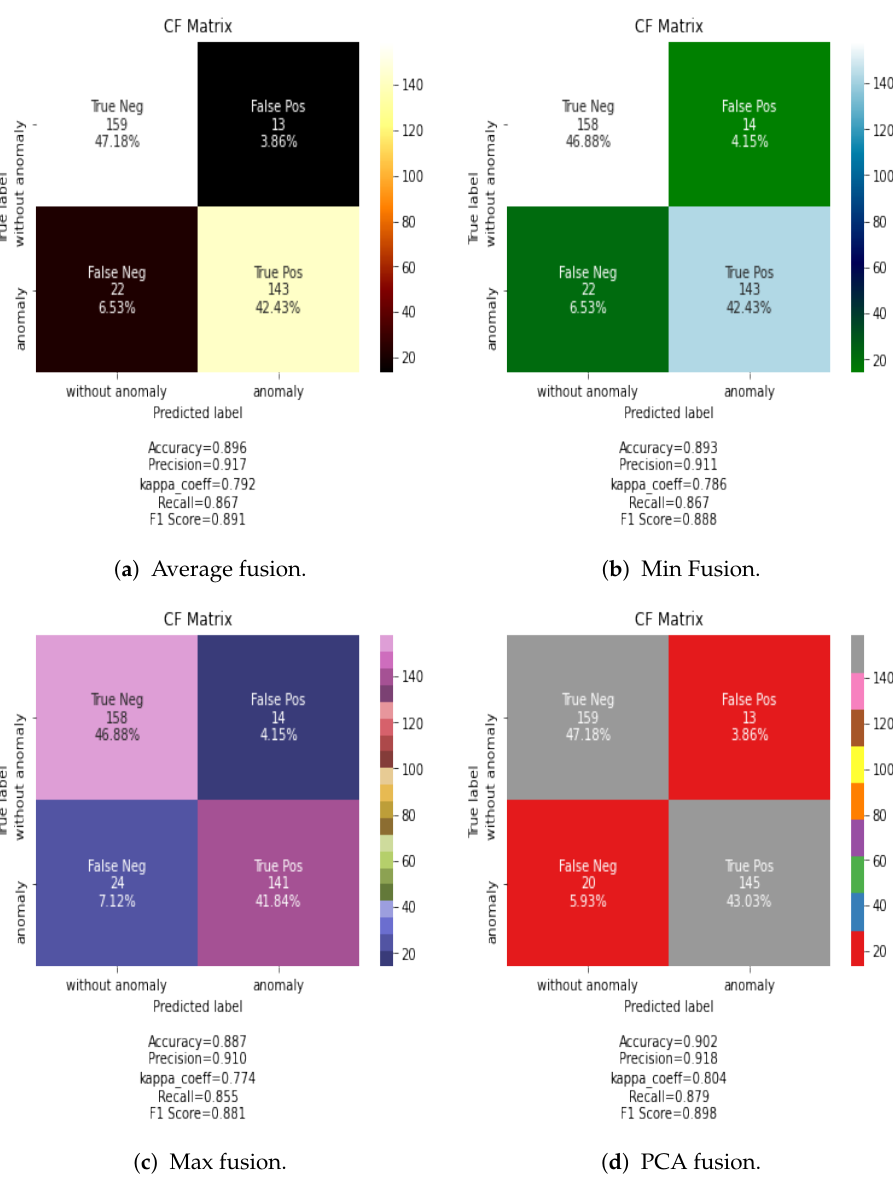
Figure 5. Confusion matrix for different spatial data fusion methods combined with the CNN